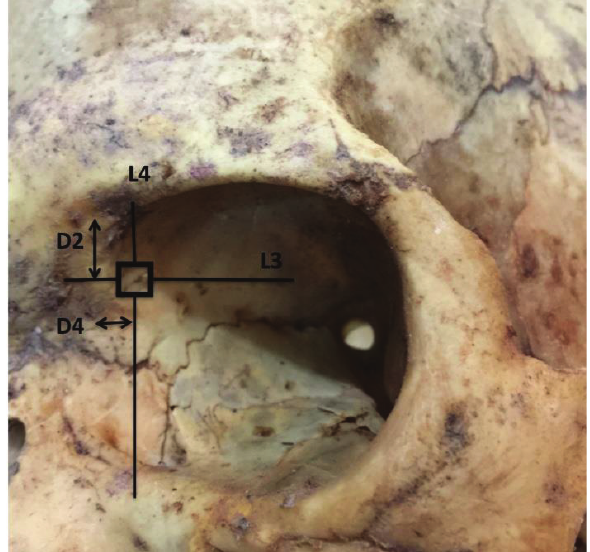
Fig-2: (L3) and (L4) are drawn perpendicular to each other through the trochlear fovea/spine. Along L1, D2 was recorded between orbital roof and L3.